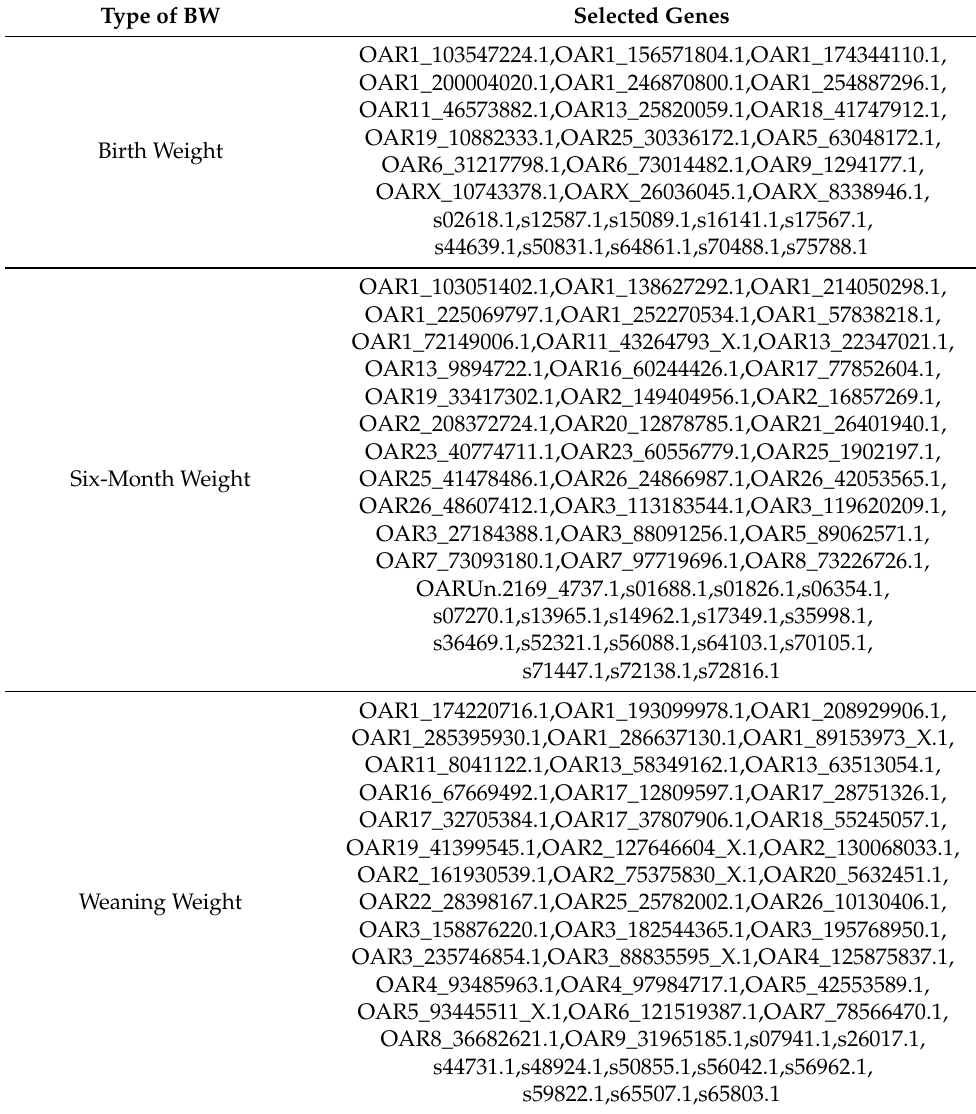
Table 4. Selected genes by using the proposed method for the body weight on the three